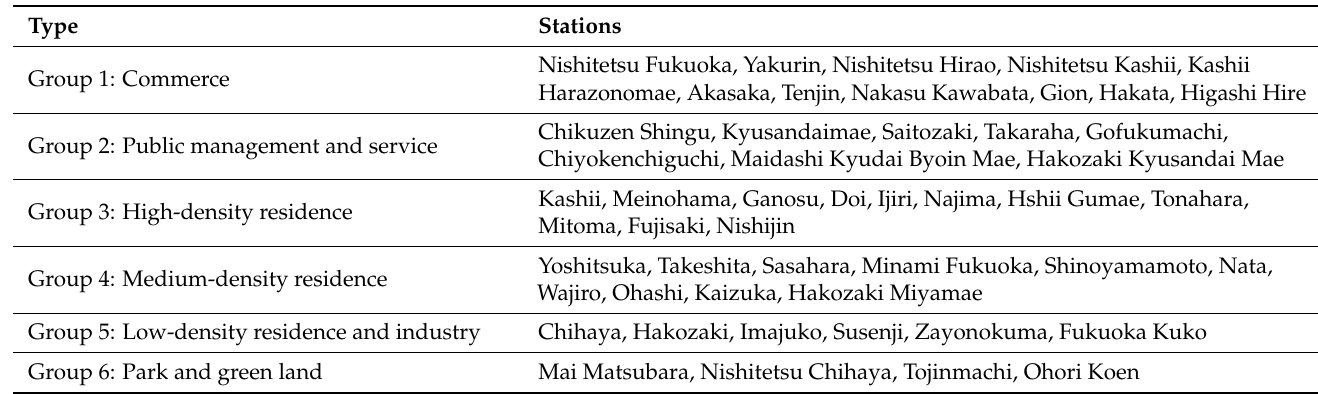
Table 9. Station classification in 0–400 m radius after cluster analysis.